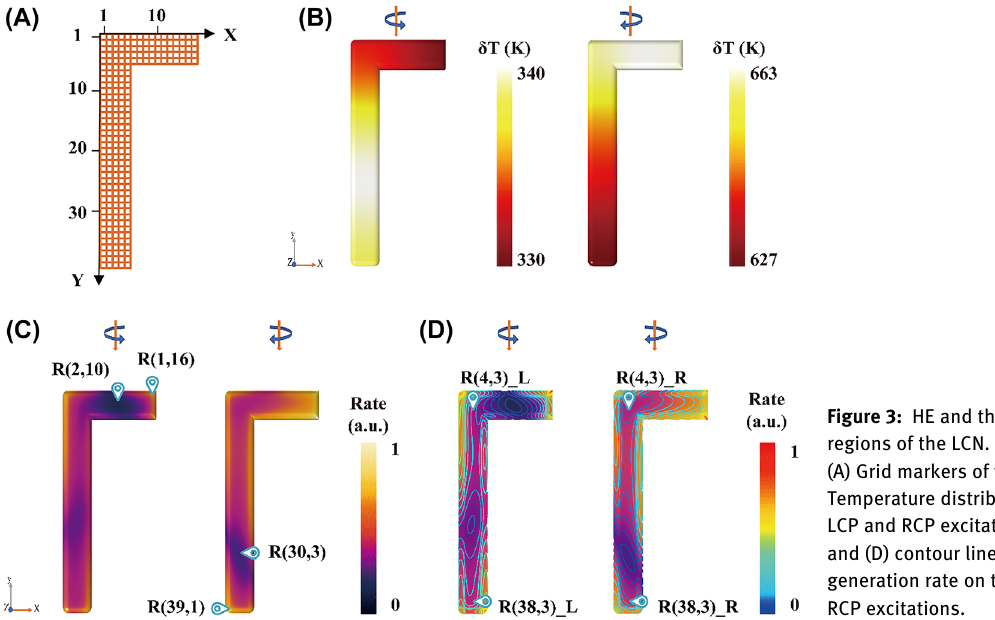
Figure 3: HE and thermal effects at different regions of the LCN.